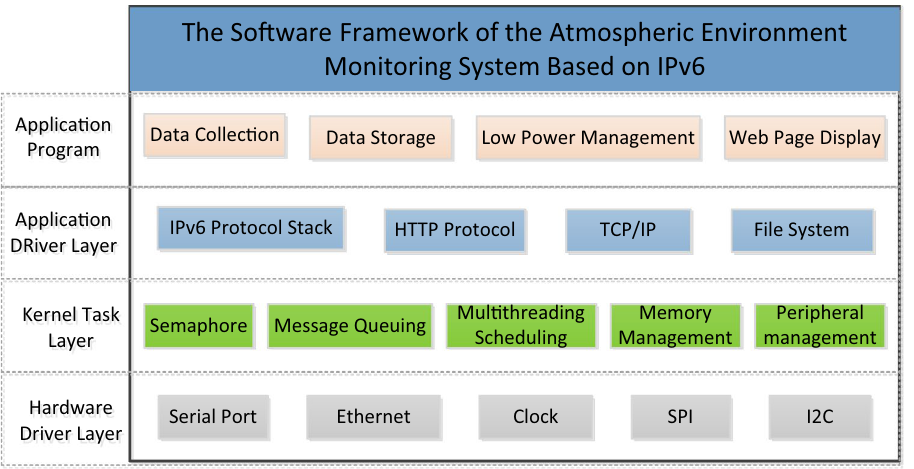
Figure 5. Overall software framework of the system.